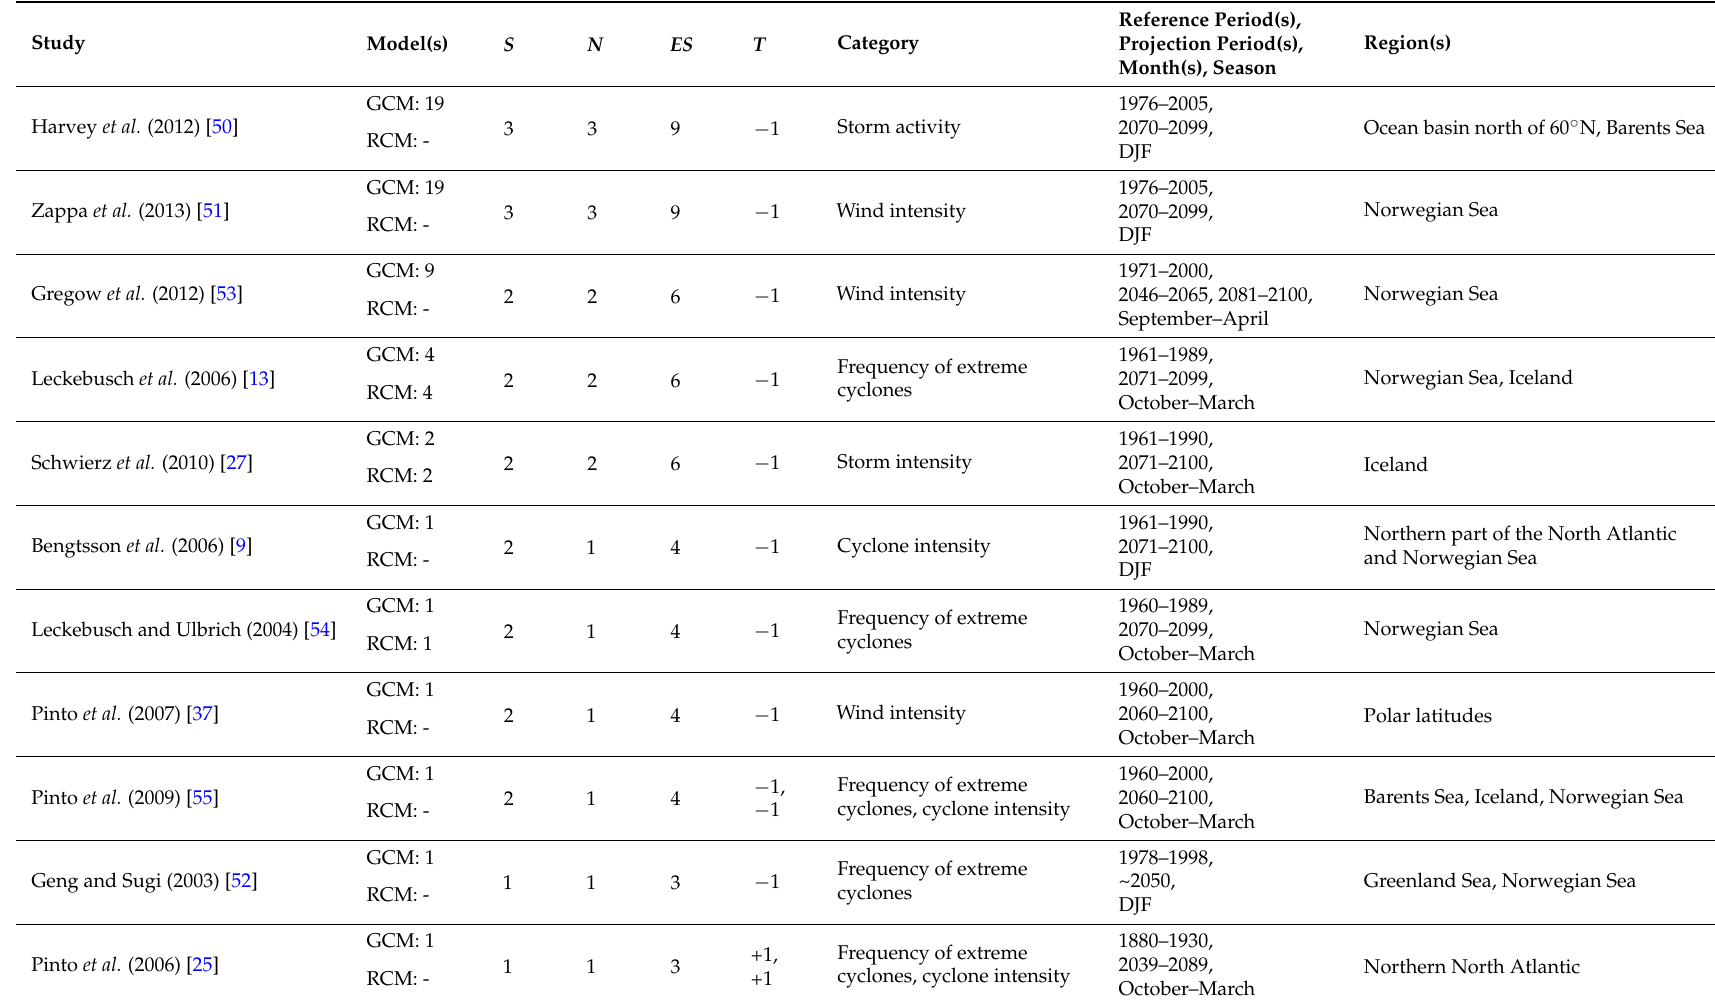
Table 1. Studies reporting on projections of aspects of future storminess in the North Atlantic subregion north of 60 ˝